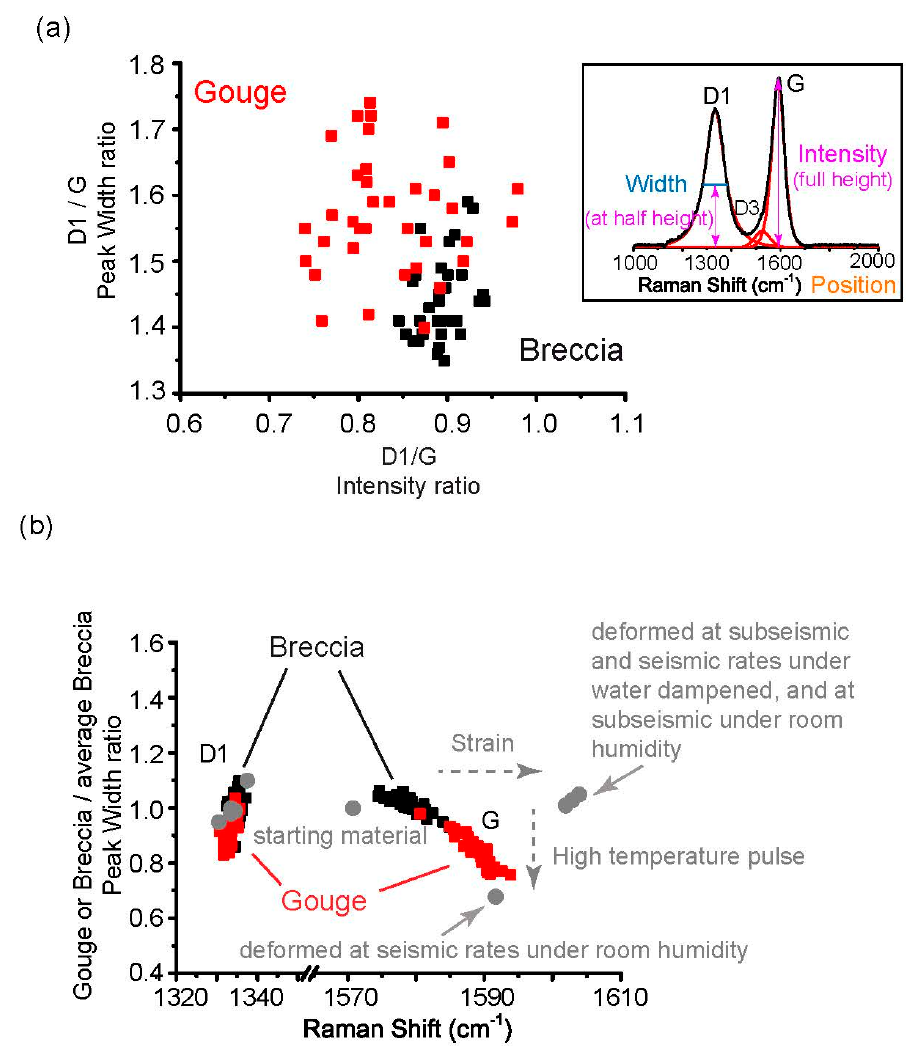
Figure 2. Raman spectra of WFSD-1 samples. ( a ) D1/G peak width ratio versus D1/G intensity ratio. The inset shows a representative first-order region of Raman spectrum and defines the indicative parameters derived from the relevant spectrum decomposition (width, intensity, peak position, etc.). ( b ) D1 or G peaks width of gouge over average breccia peak width versus D1 and G band peak position. Grey circles representing the experimental results obtained from Kuo et al. [17], and the grey dashed arrows showing the variation of Raman spectra after rock friction experiments under varied ambient conditions and slip rates, attributing to strain and high temperature pulses.